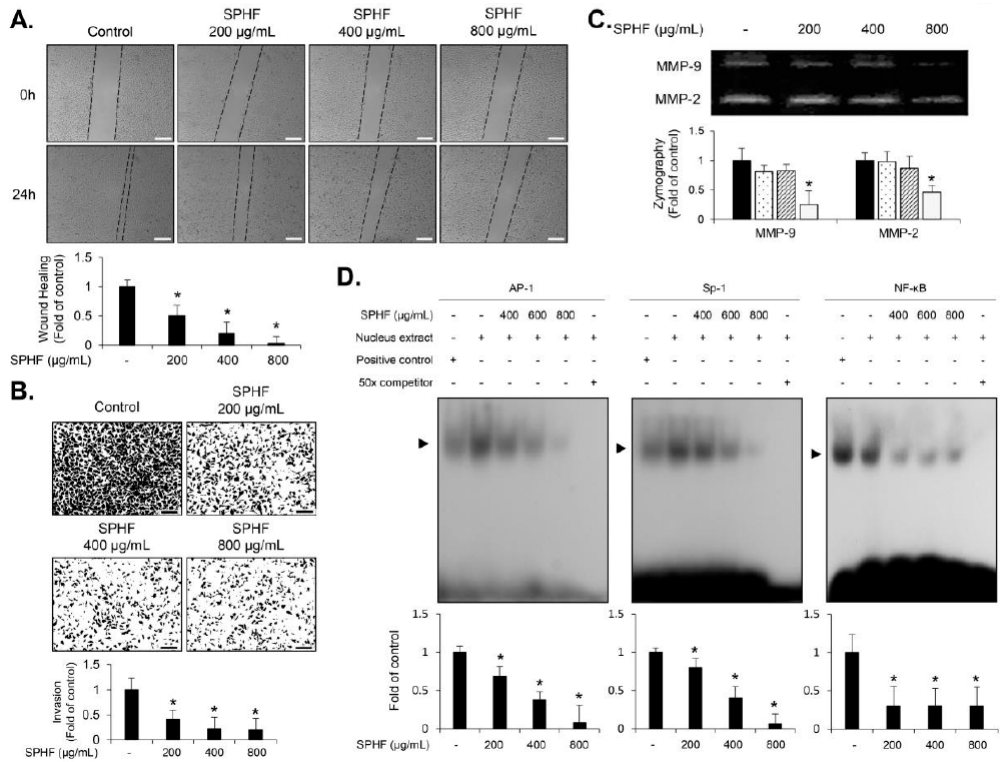
Figure 4. SPHF inhibited EJ cell migration and invasion via repression of MMP-9 activity by attenuating the binding activity of transcription factors. The cells were treated with di ff erent concentrations of SPHF for 24 h. ( A ) The inhibitory e ff ects of SPHF on cellular migration were determined using a wound-healing migration assay (scale bars = 200 µ m). ( B ) Invasive potential was evaluated with Matrigel-coated transwell plates in SPHF-treated cells (scale bars = 200 µ m). ( C ) Changes in MMP-2 and MMP-9 activity were investigated via SPHF-treated cell zymography. ( D ) The EMSA assay was used to determine the transcriptional binding activity of NF- κ B, AP-1, and Sp-1. The values in the bar graphs represent the mean ± SD of three independent experiments and all fold changes are relative to the control; * p < 0.05 relative to the non-treated